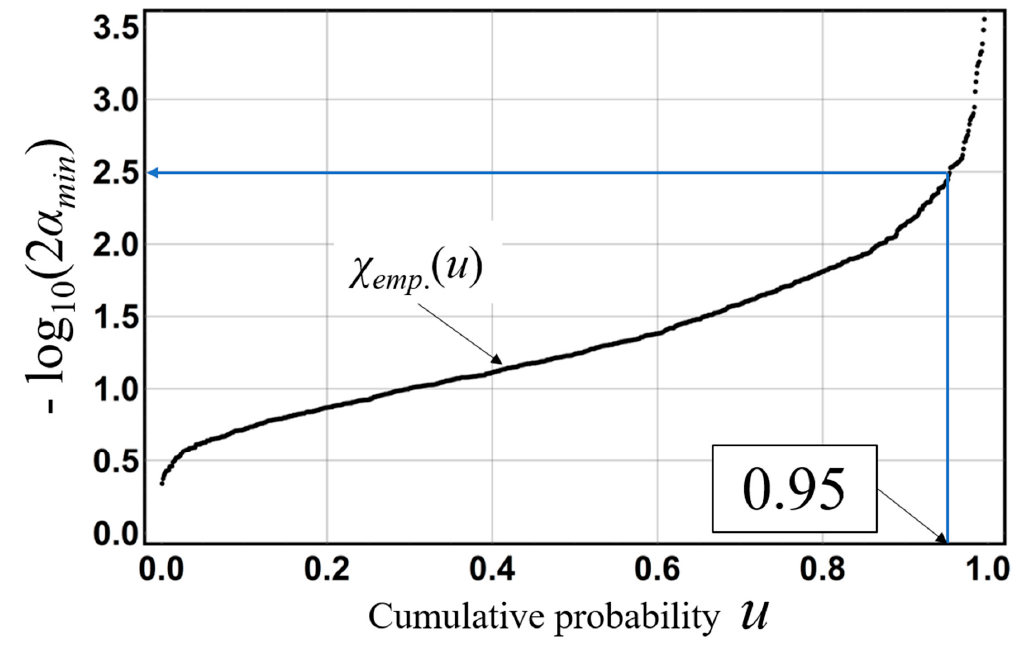
Figure 5. Empirical representing function χ emp ( u ) constructed from 1000-datum set of − log 10 (2 α min ) values.